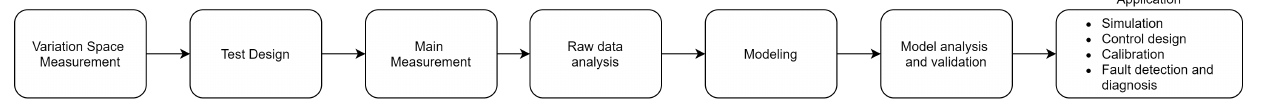
Figure 1. Workflow for experimental engine modeling with test